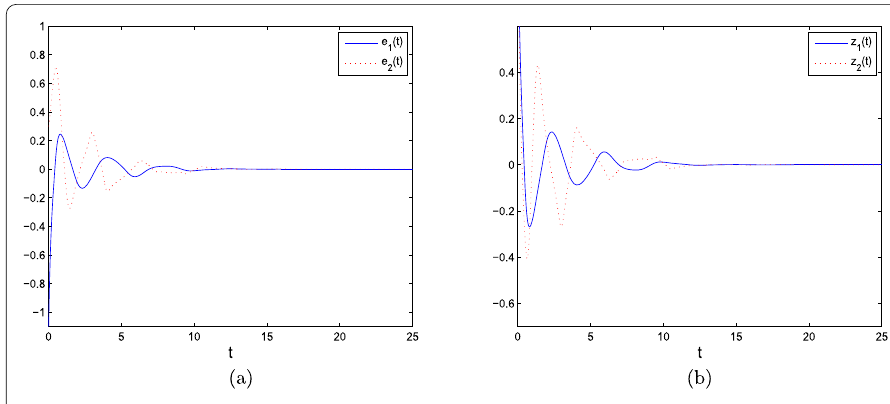
of synchronization errors and the synchronization curves with nonlinear feedback con- troller (24) between drive–response systems (22) and (23) are shown in Figs. 1(a) and (b), and Figs. 2(a)–(d), where the initial values of drive system (22) are chosen as x 1 ( θ ) = 0.3, x 2 ( θ ) = 0.6, y 2 ( θ ) = 4, and y 2 ( θ ) = –4 and θ ∈ [0,1]. Also, the initial values of response system (23) are chosen as u 1 ( θ ) = –0.9, u 2 ( θ ) = 0.9, v 2 ( θ ) = –0.7 and v 2 ( θ ) = –0.8, and θ ∈